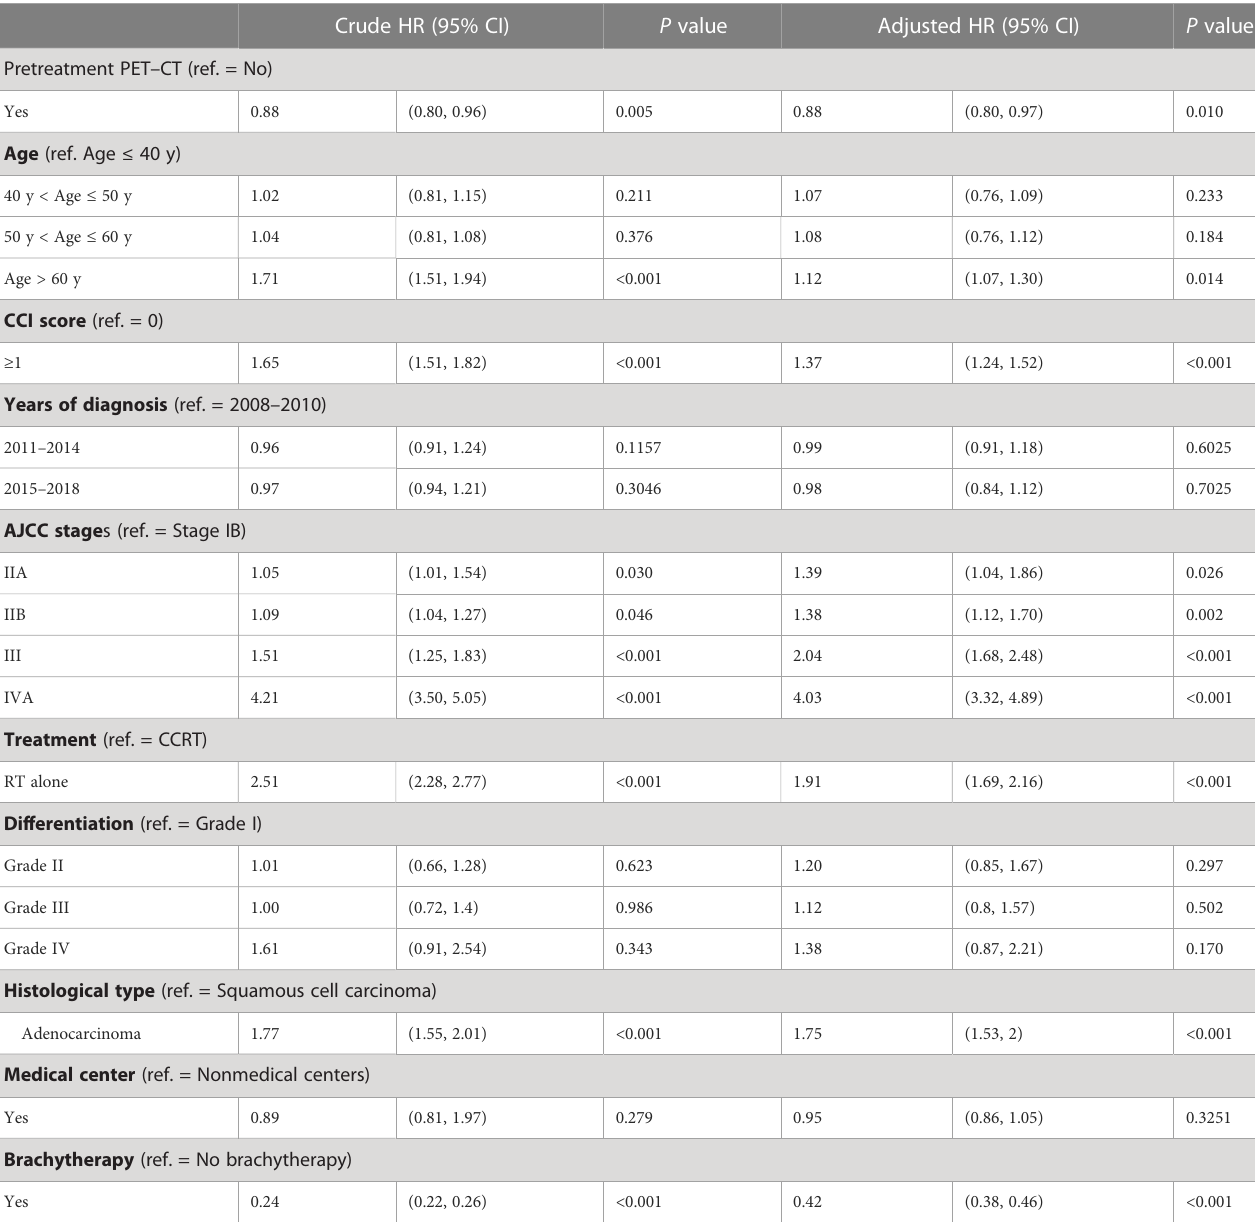
TABLE 2 Cox proportional hazard regression analysis of the risk of all-cause death in propensity score – matched patients with cervical